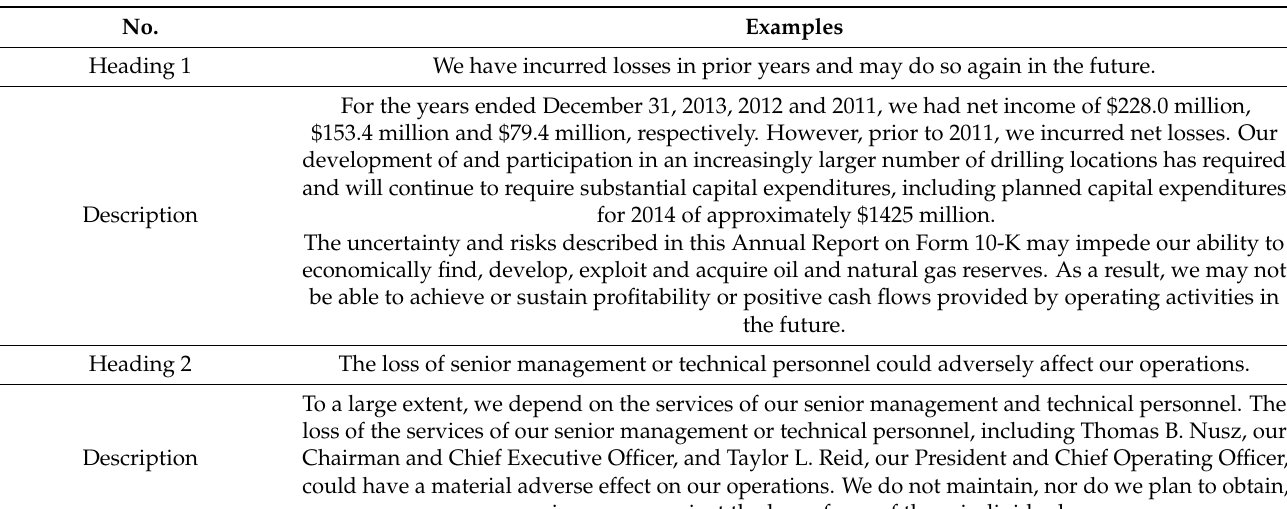
Table 1. The examples of Headings and their description in RFD of Form 10-K.